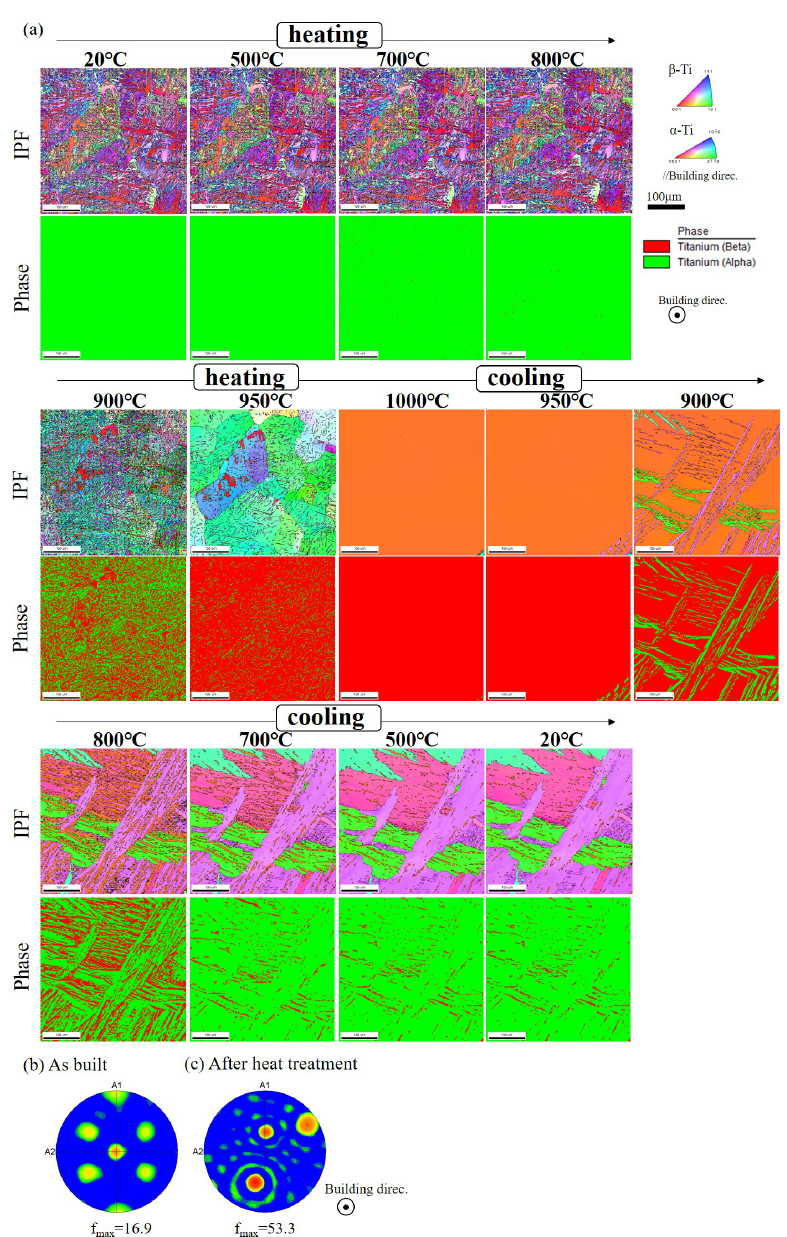
Figure 7. ( a ) Changes in inverse pole figure maps and phase maps during heat treatment. ( b , c ) { 10¯10 } pole figures of α -Ti at room temperature before ( b ) and after ( c ) heat treatment determined by